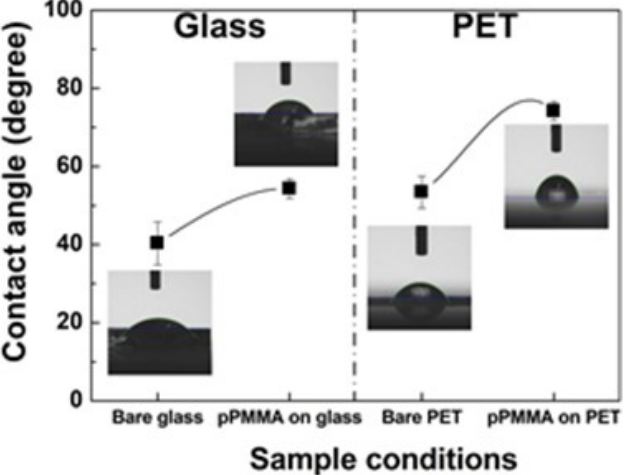
Figure 7. Variation in the water contact angles (WCAs) on the pristine (bare) substrates and pPMMA thin films grown on glass and polyethylene terephthalate (PET) substrates when using the proposed APP polymerization technique after 90 min deposition. Insets represent photographs of the water droplets on the pristine and pPMMA film.